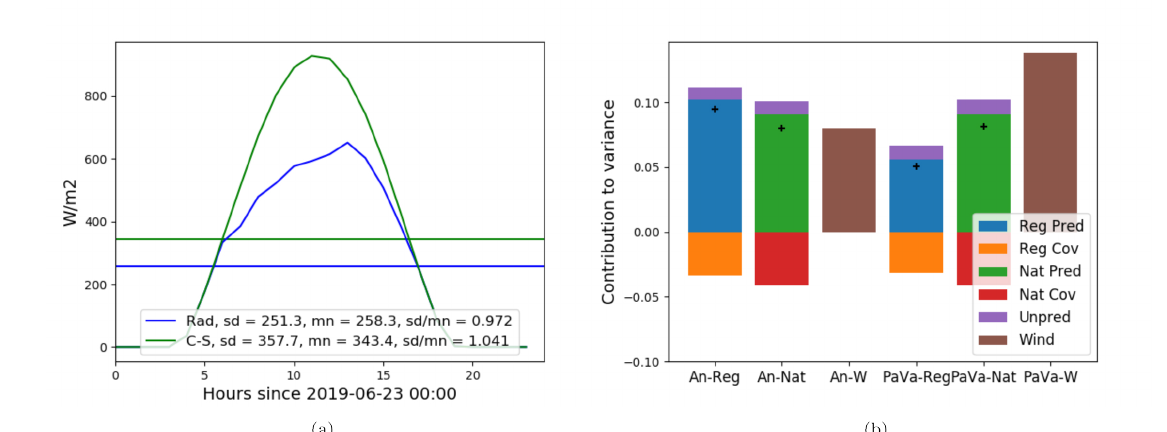
Figure 2. Analysis of the ( a ) motivation and ( b ) effect of the proposed methodology. ( a ) Hourly values of MERRA-2 surface downward shortwave solar radiation (blue line) and clear-sky values (green line) for an sample illustrative day. Daily means are represented with horizontal lines. Inset table includes a legend and the statistical summary for the two series—mean (mn), standard deviation (sd) and the ratio between the two. ( b ) Analysis of the contributions to the regional variance for Andalucia (An) and Pais Vasco (PaVa). An-Reg and PaVa-Reg show: regional predictable (blue), regional unpredictable (purple) and covariance between them (orange). An-Nat and PaVa-Nat show: national-averaged predictable (green), regional unpredictable (purple) and national-averaged regional covariances between predictable and unpredictable contributions (red). Black crosses represent the additions of all the terms of the variance. An-W and PaVa-W show the total variance of the wind generation in brown